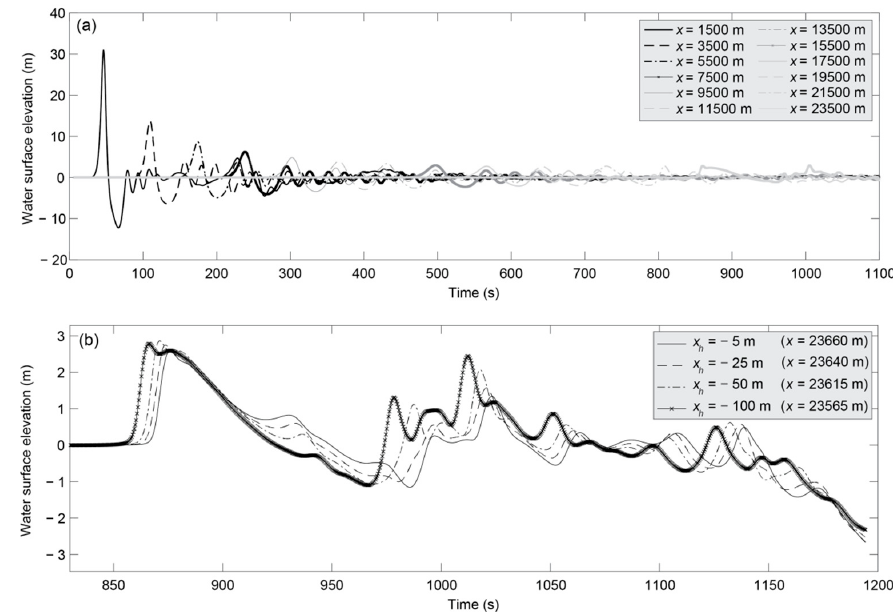
Figure 11. Time history of the water surface elevation measured along the slide axis for scenario 2; ( a ) relative to the slide impact point ( x = 0 m) and ( b ) relative to Marina de Formentera ( x h = 0 m and x = 23,665 m).